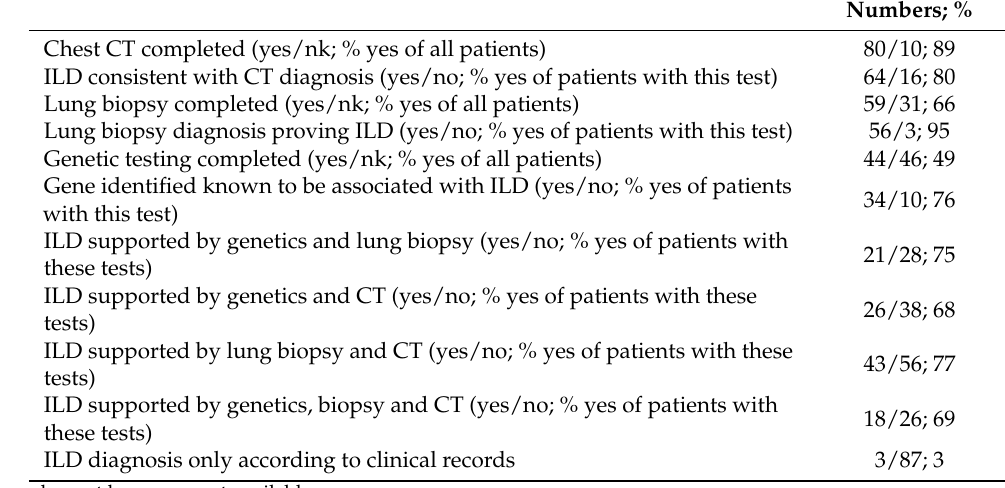
Table 5. ILD diagnosis supported by the results of the diagnostic tests used in the cohort of 90 patients with immunodeficiency.